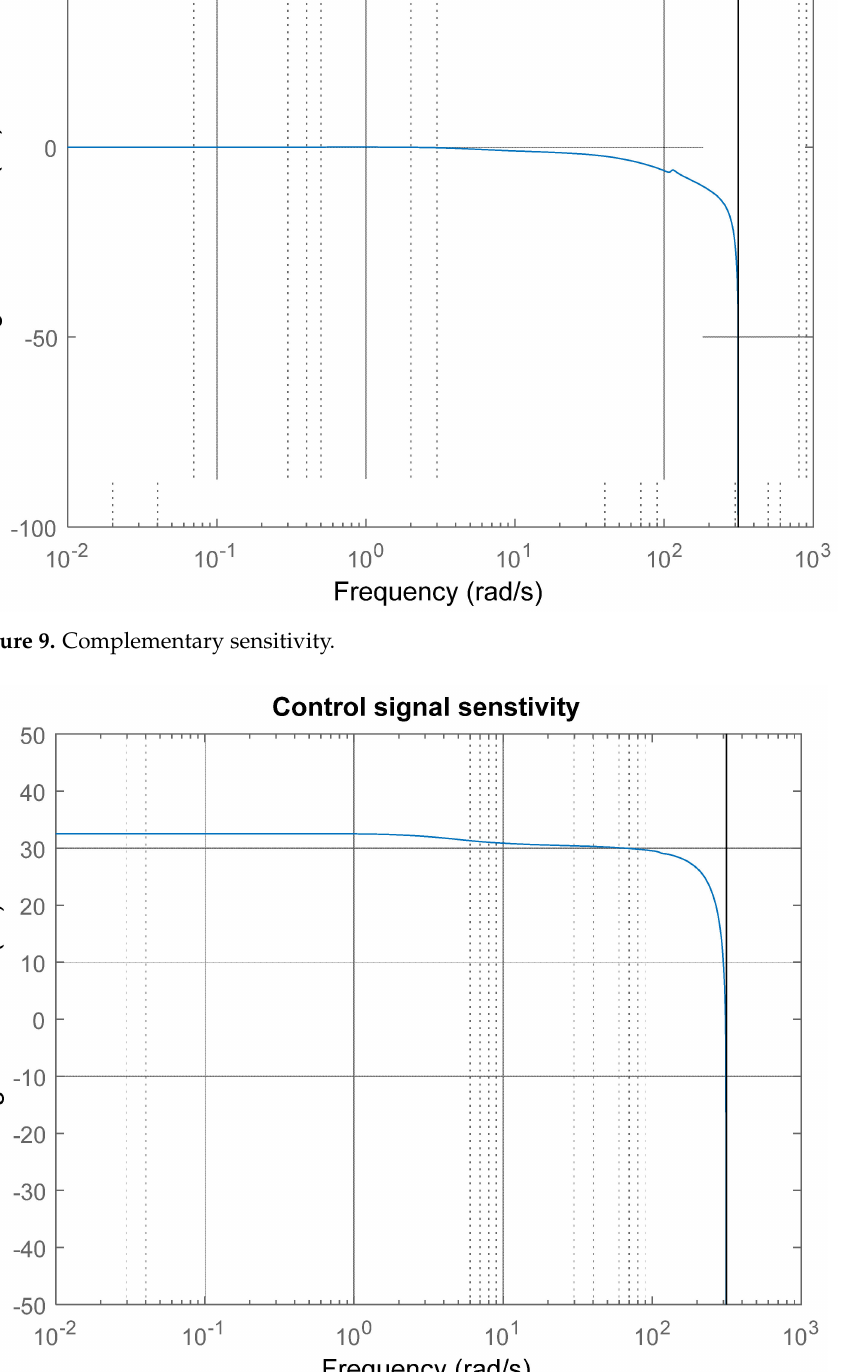
Figure 10. Control signal